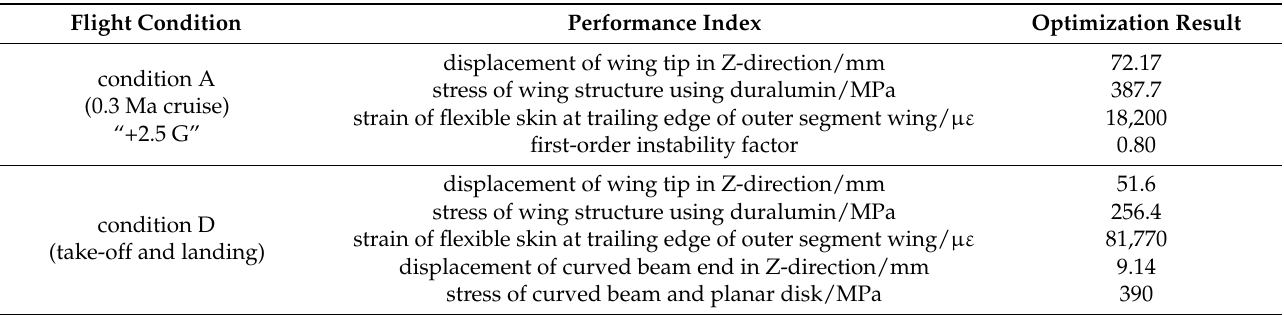
Table 12. Optimization results of wing structure performance